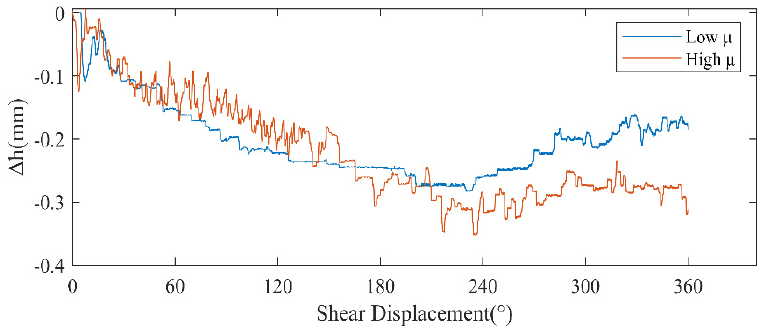
Figure 2. Vertical displacement versus shear displacement of glass beads and spherical corundum at